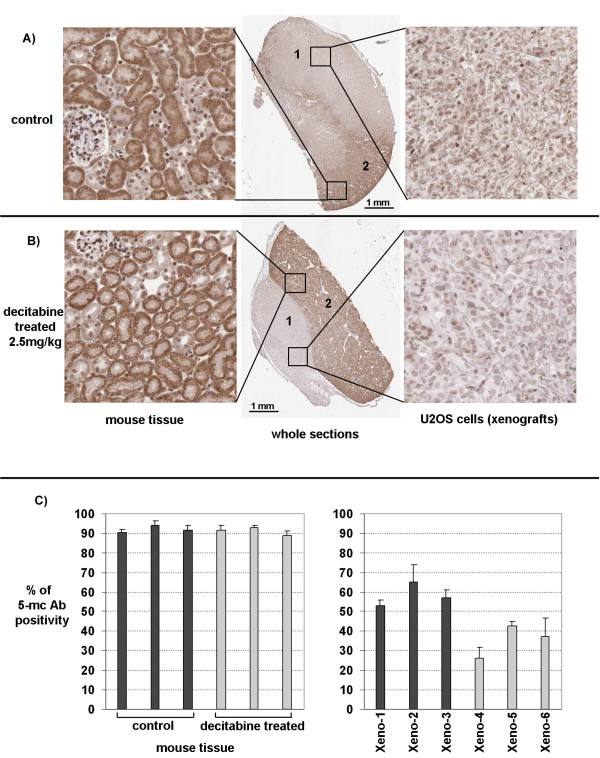
Analysis of differential 5-methylcytidine content of U2OS xenografts using histological sections. Analysis of the relative levels of cellular 5-methylcytidine within xenografts derived from representative control untreated mice (panel A); or decitabine treated mice (panel B) using immunohistochemical staining with 5-mc-Ab. To the right a 20X enlargement of representative U2OS histology is shown. More 5-mc-Ab staining is evident in the nuclei from control sections (panel A-right side) in comparison to nuclear staining in the sections derived from decitabine treated mice (panel B right side). These data are consistent with a reduction in 5-methylcytidine nuclear content in U2OS xenografts derived from mice treated with decitabine. Enlargements of darkly stained host murine kidney cells correspond to heavily methylated differentiated renal tissue (denoted 2 in panels A and B). In panel C the staining intensity from control (dark columns) and decitabine treated (light columns) is quantitated using Aperio scanning image analysis of sections. The graph to the right of panel C confirms that the 5-mc-Ab staining in control untreated (dark columns) U2OS xenograft sections is more intense than the decitabine treated (light columns) U2OS xenografts. This decrease in staining intensity was significant (p < 0.05). In contrast host kidney cells from both control and treated mice do not exhibit any significant difference in staining intensities.